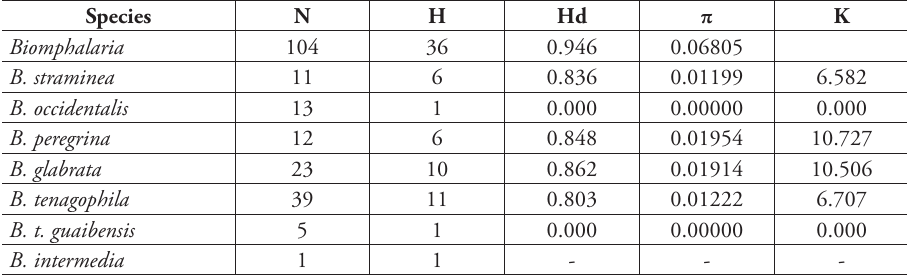
Table 3. Sample size (N), number of haplotypes (H), haplotype diversity (Hd), nucleotide diversity (π, Nei 1987, equation 10.5) and average number of nucleotide differences (K, Tajima 1983, equation A3) calculated in DNAsp v.5 (Librado and Rozas 2009) for a 549 bp region of the COI gene in the six Biom- phalaria species and one Biomphalaria